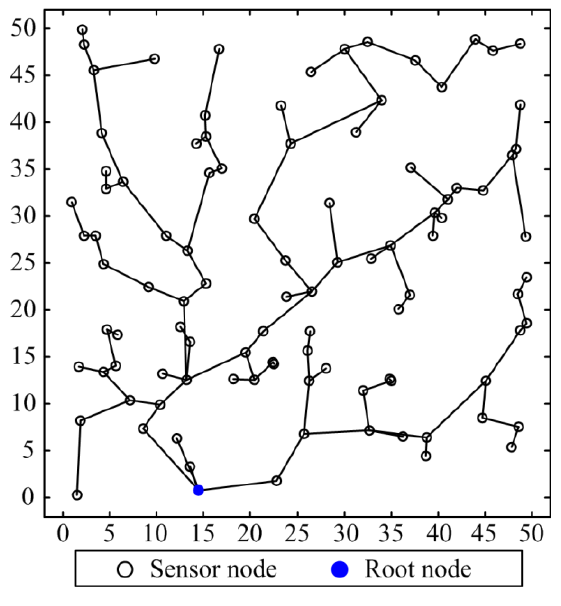
Figure 3. Data transmission paths using the ECHR algorithm for a specific network